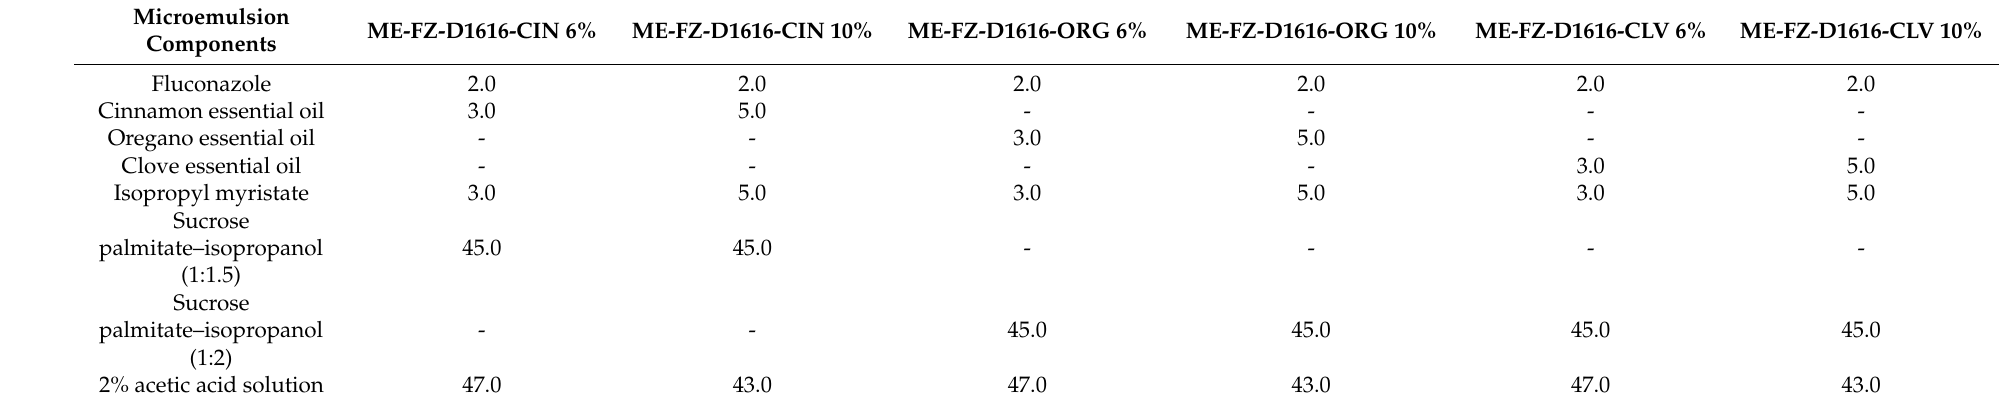
Table 1. Composition (%, w / w ) of fluconazole-loaded microemulsions based on sucrose palmitate.